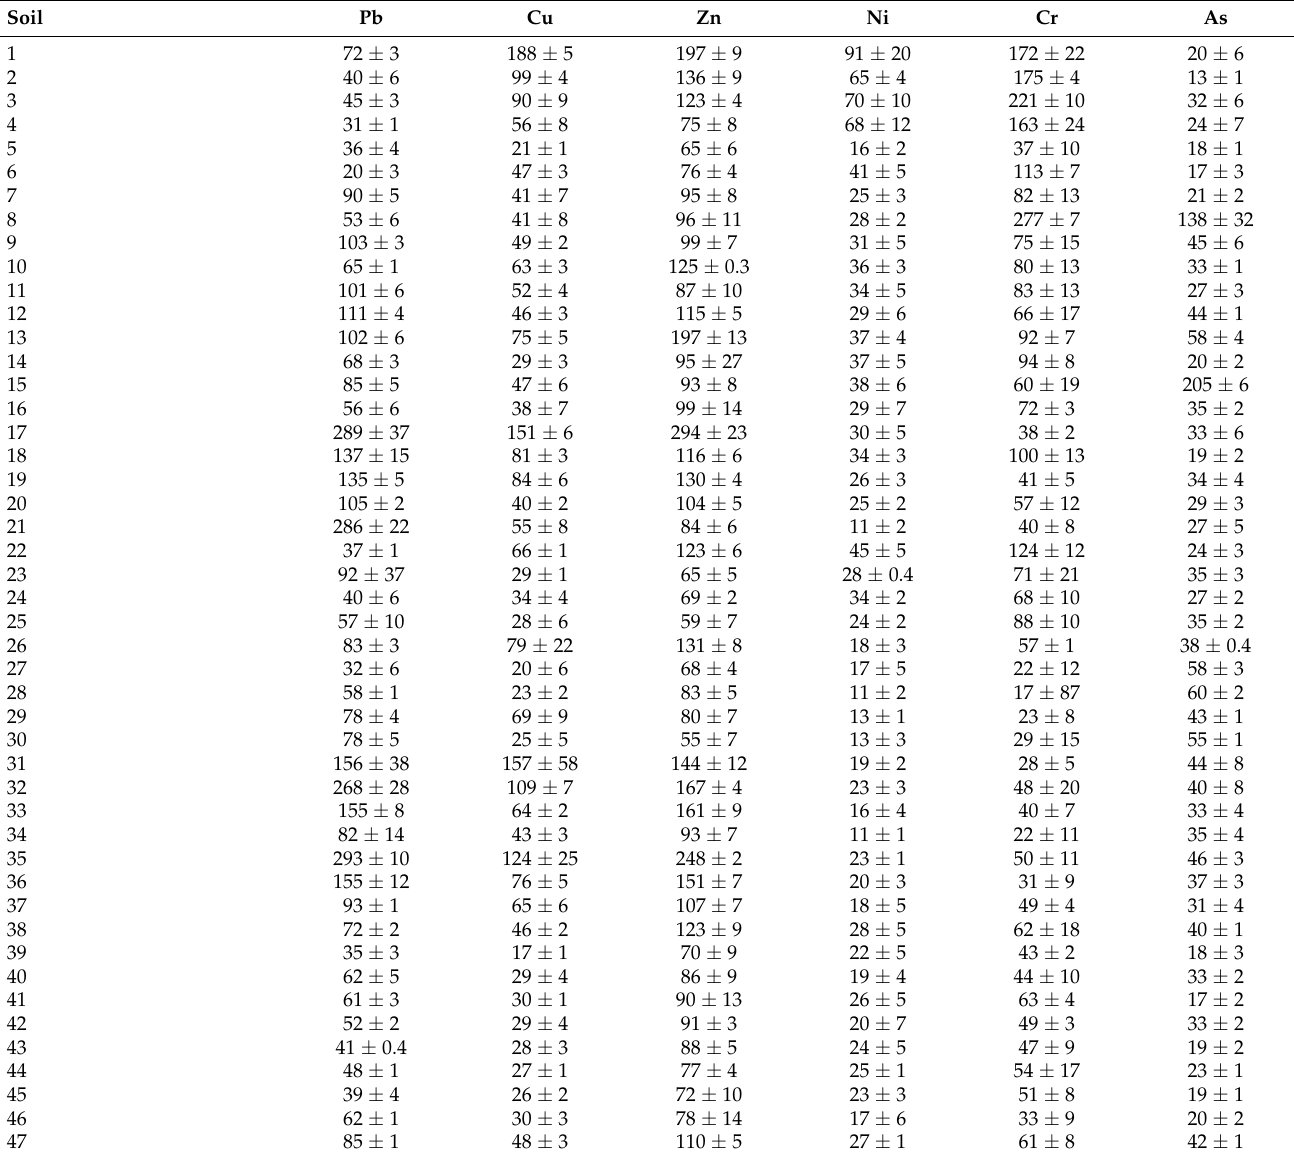
Table 3. Trace element concentrations in urban soils (in mg kg − 1 , mean ± standard deviation, n = 3).